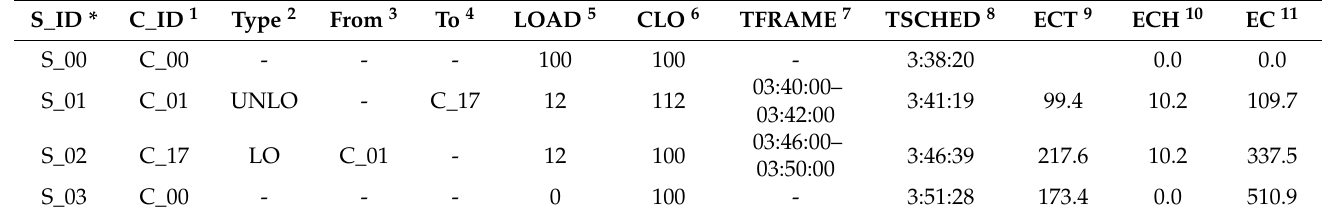
Table 6. Numerical results of the conventional optimization of real-time supply demands performed by the milk-run trolley within the additional route 4.